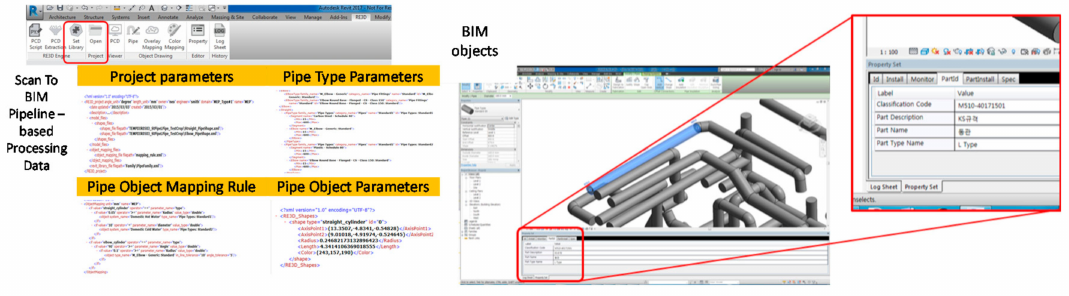
Figure 13. BIM Object Property Mapping Results in